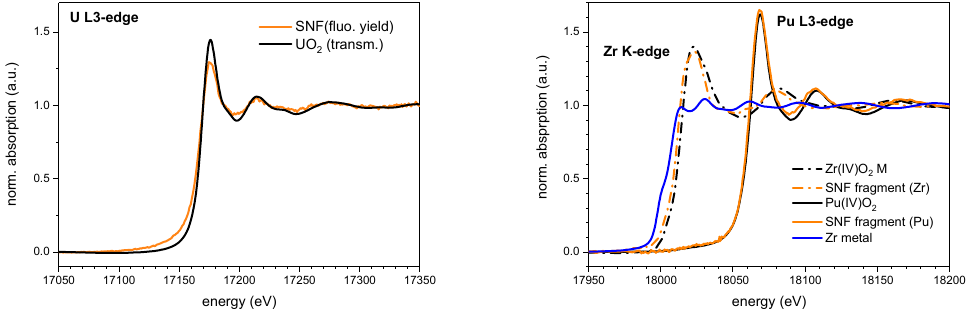
Figure 7. ( left ) U L3-XANES and ( right ) Zr K- and Pu L3-XANES obtained for the Gösgen fuel fragment (orange traces) together with oxide reference spectra (black traces) and Zr metal calibration spectrum (blue).